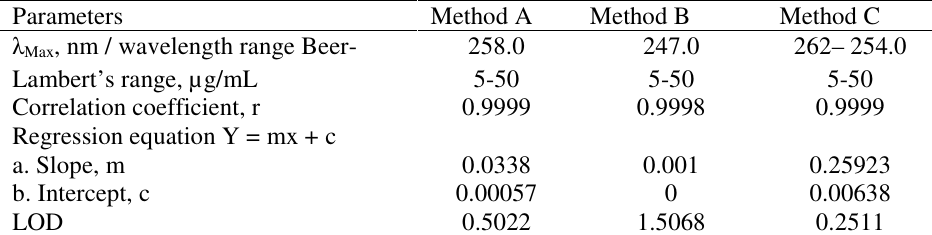
Table 1. Optical characteristics and other